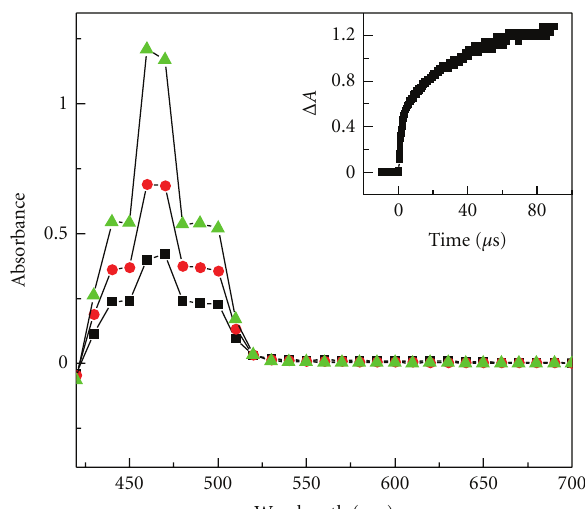
Figure 3: Electronic absorption spectra obtained during photolysis of the dye 1 (0.1 mM) and Tz (1mM) in MP in the presence of air. Irradiation intensity 2 × 10 16 quants − 1 . The spectrum recorded before (a) 0 s and after (b) 5 s, (c) 10s, (d) 15s, and (e) 20 s